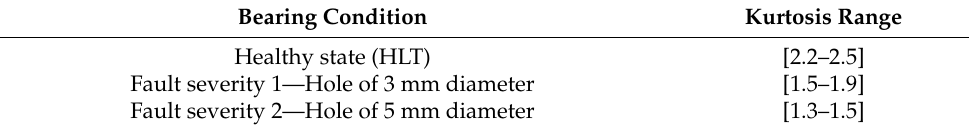
Table 4. Ranges for condition detection according to the kurtosis statistical indicator.